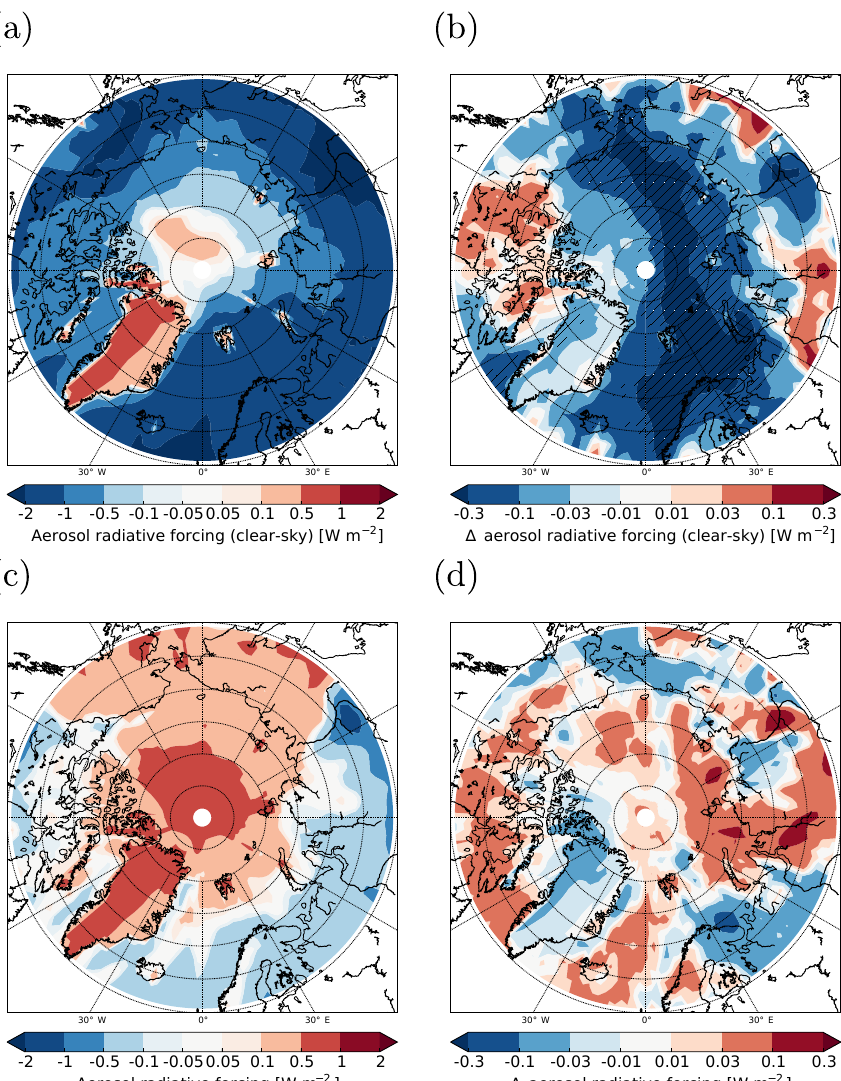
Figure 13. Aerosol radiative forcing in late summer (July–August) 2050: (a, b) under clear-sky and (c, d) under all sky conditions. On the left side, absolute values for 2050 (reference) are shown. On the right side, the difference between a simulation with enhanced ship emissions and the reference simulation is displayed (difference between arctic_2050_shipping and arctic_2050). Hatched areas are significant at the 95% confidence